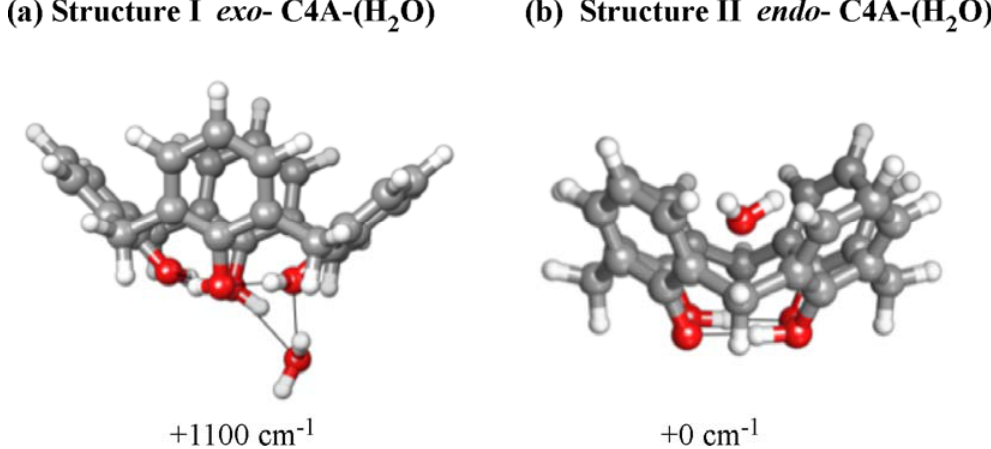
Figure 18. (a) Optimized structures of the exo - (Structure I) and endo -isomers (Structure O) complex obtained at the MP2/aug-cc-pVDZ level of theory. The II) of the C4A-(H 2 1 numbers shown in cm -1 are electronic energies relative to that of endo -isomer. Figure adapted from Reference